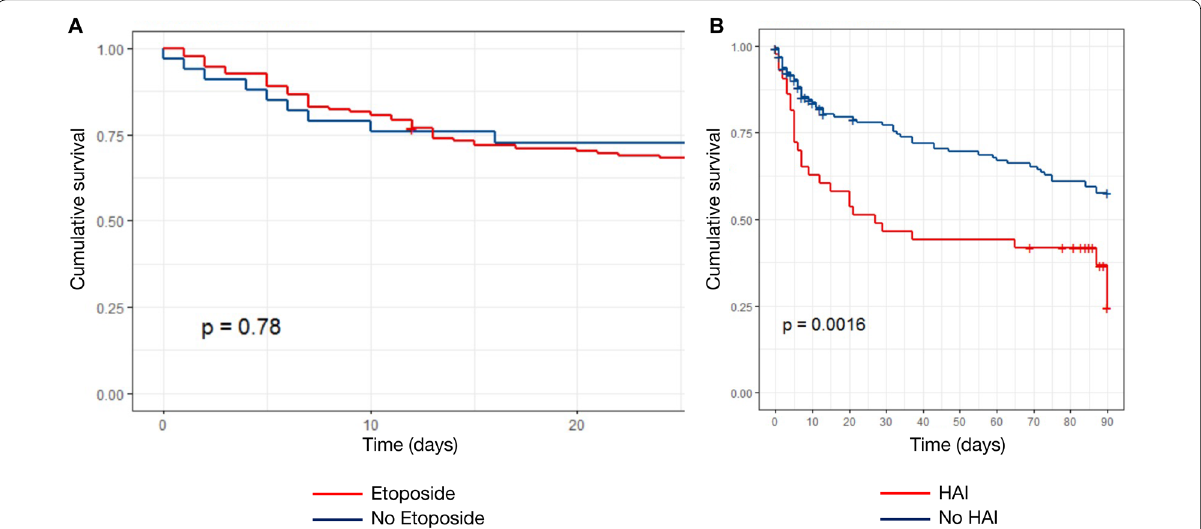
Fig. 1 Cumulative survival according to A etoposide status and B HAIs status (Kaplan–Meier’s estimates, log-rank’s test)